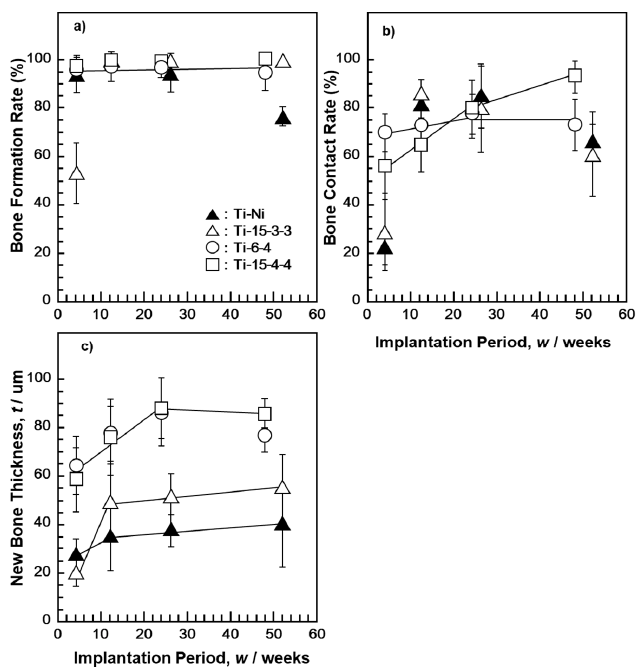
Figure 4. New bone formation rate ( a ), bone contact rate ( b ), and new bone thickness ( c ) for Ti–Ni,